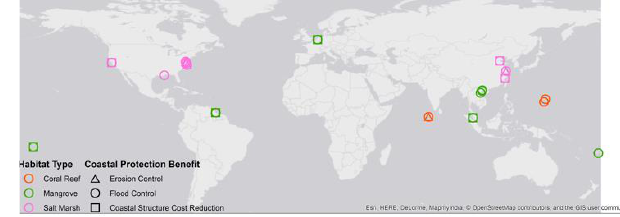
Figure 5 . Various coastal protection for specific hazard (n = 52). (Li et al., 2017)